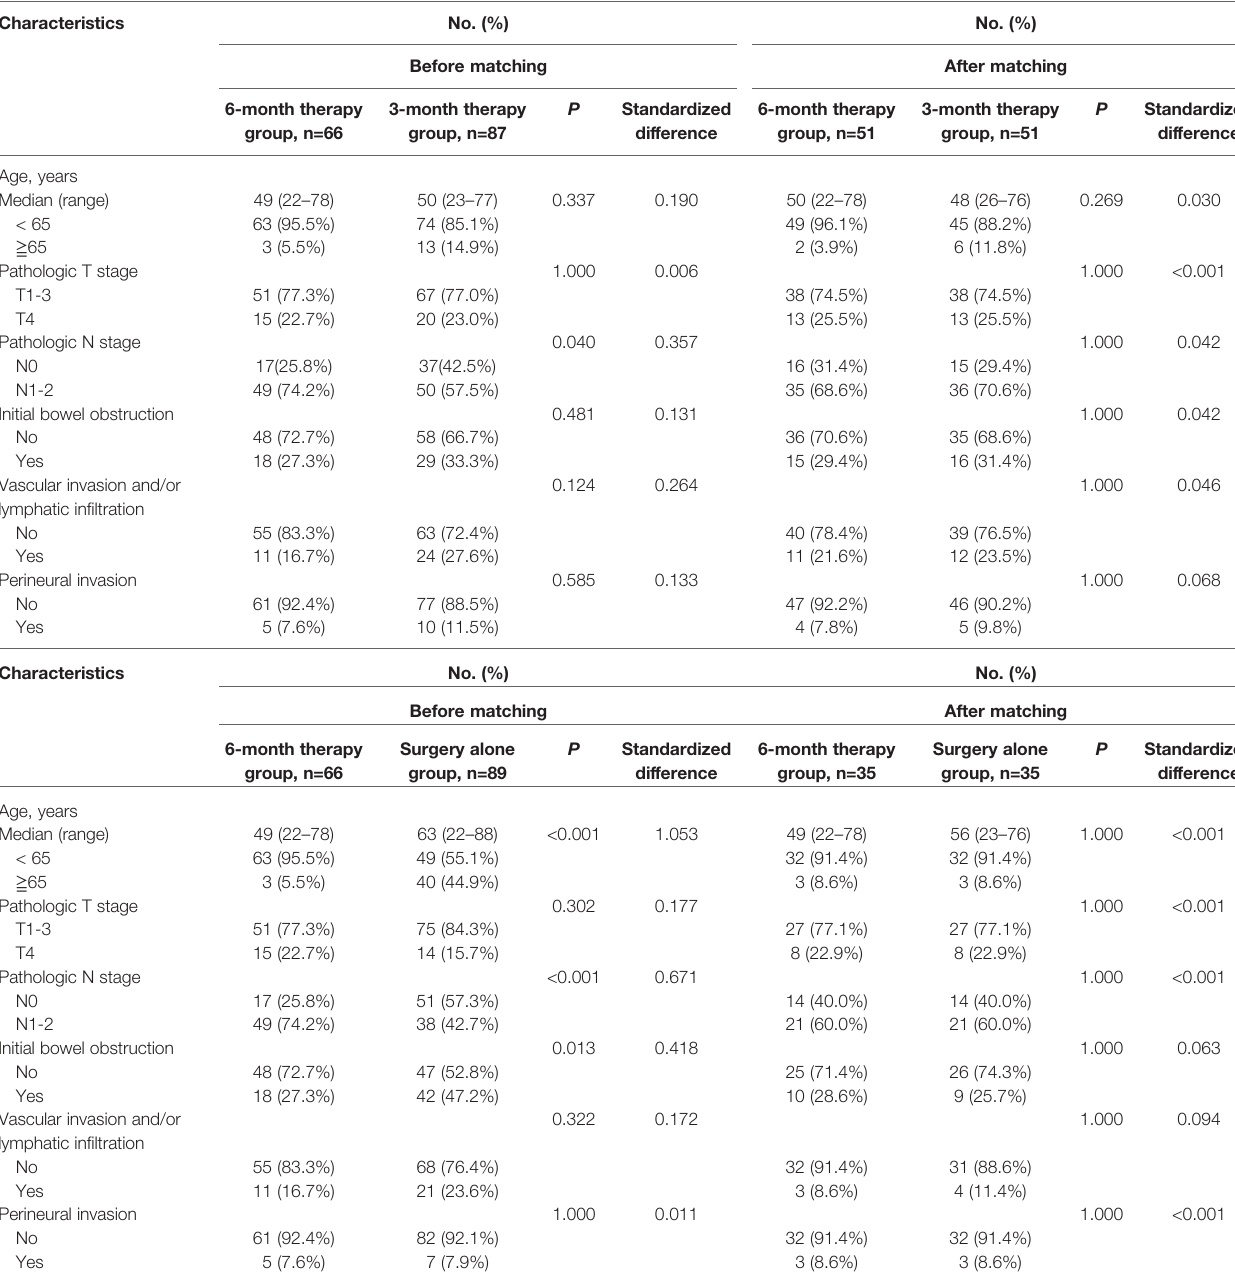
TABLE 3 | Selected baseline characteristics before and after propensity score matching.